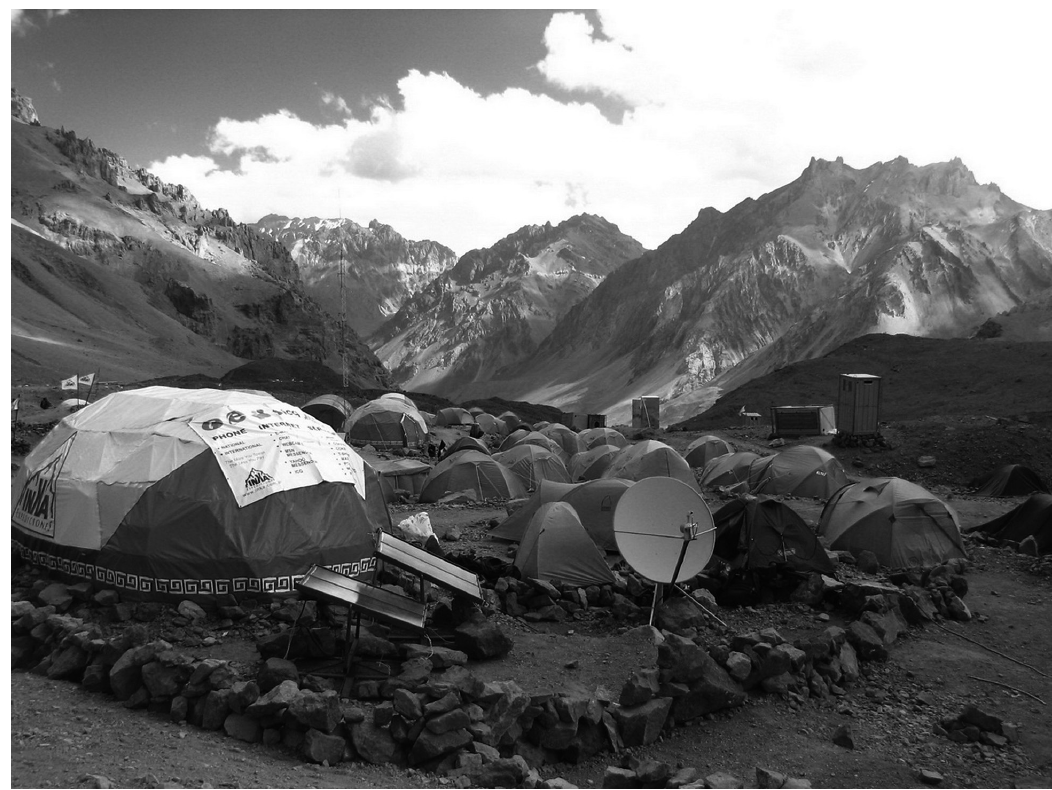
Fig. 2. The development of main base Plaza de Mulas.